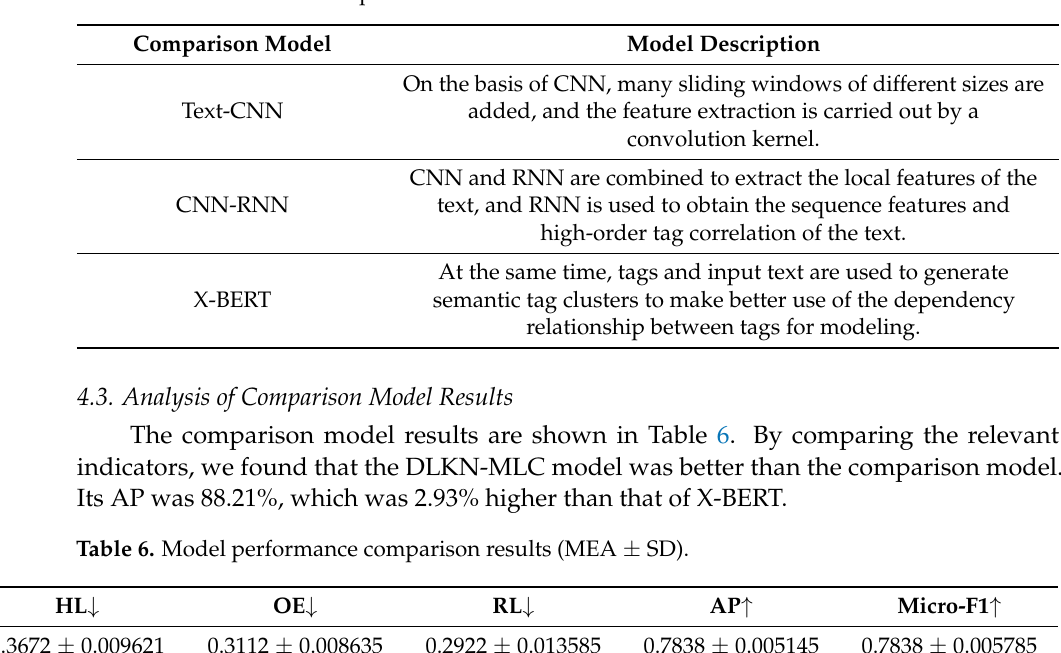
Table 5. Introduction to comparison model.